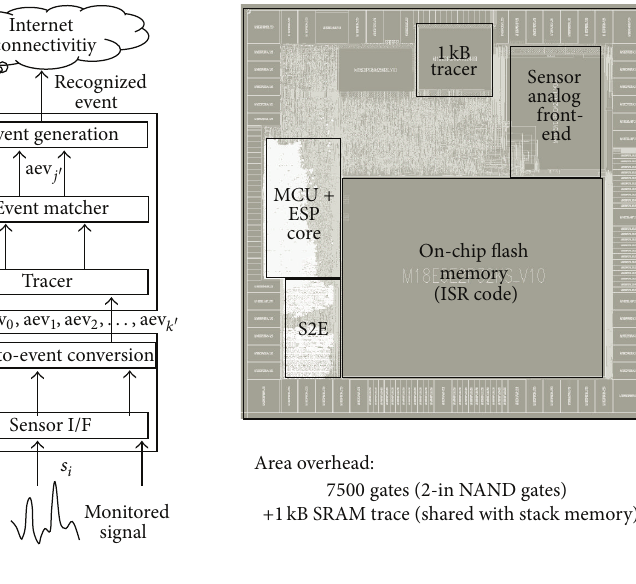
NAND for the timer counter, signal-to-event converter (S2E) including AEG blocks, event-print window matcher in EPU unit, and 1-KB SRAM buffer for the atomic event vector